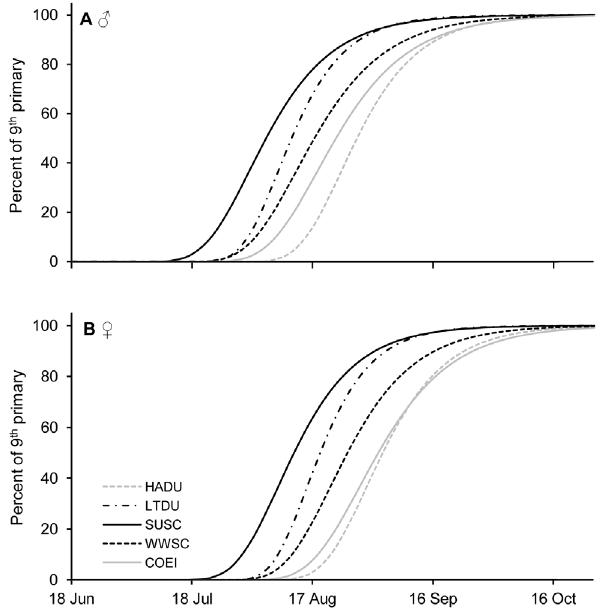
Figure 1. Feather growth rates of the 5 seaduck species. Gompertz 9 th primary growth models for 5 seaduck species; Harlequin Ducks ( Histrionicus histrionicus , HADU), Long-tailed Ducks ( Clangula hyemalis , LTDU), Surf Scoters ( Melanitta perspicillata , SUSC), White- winged Scoters ( Melanitta fusca , WWSC) and Common Eiders ( Somateria mollissima dresseri , COEI) with ( A ) representing males and ( B ) females.